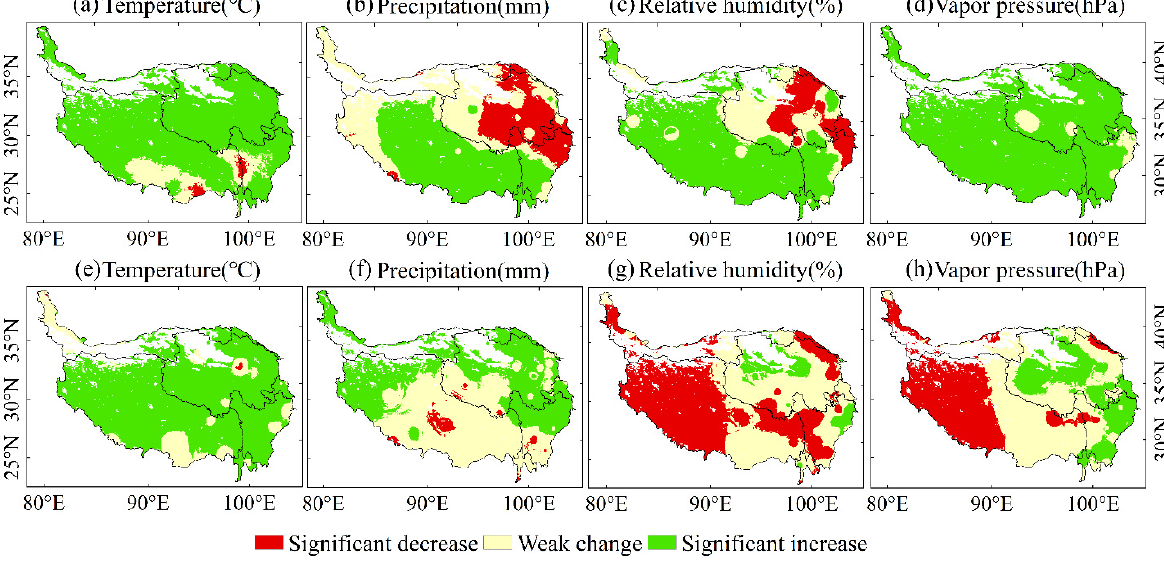
Figure 5. Significance of the trends in climatic variables from 1981 to 2000 ( a – d ) and from 2001 to 2019 ( e – h ) in the QTP using the modified MK test.